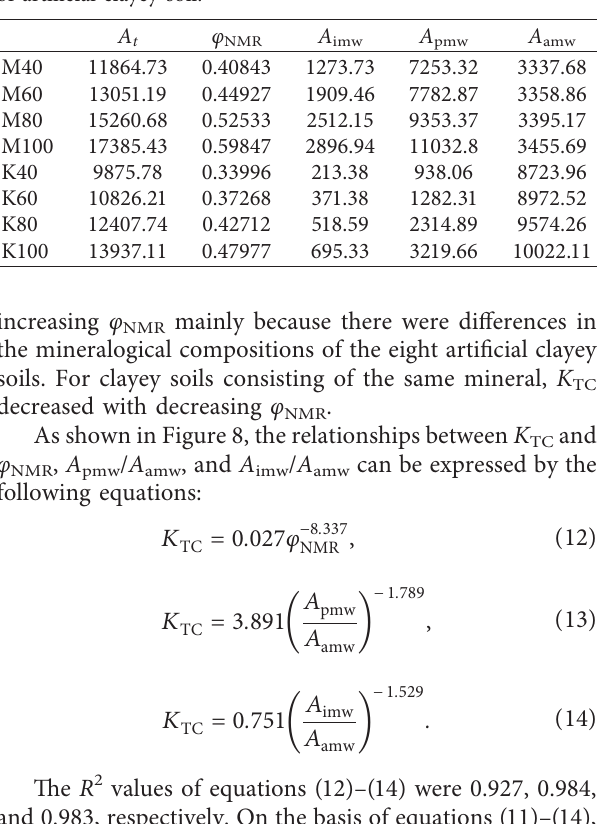
Figure 7: Double T 2 cut-offs of the eight artificial clayey soils: (a) K40, (b) K60, (c) K80, (d) K100, (e) M40, (f) M60, (g) M80, and (h) M100. Table 3: A t , φ NMR , A imw , A pmw , and A amw values of the eight kinds of artificial clayey